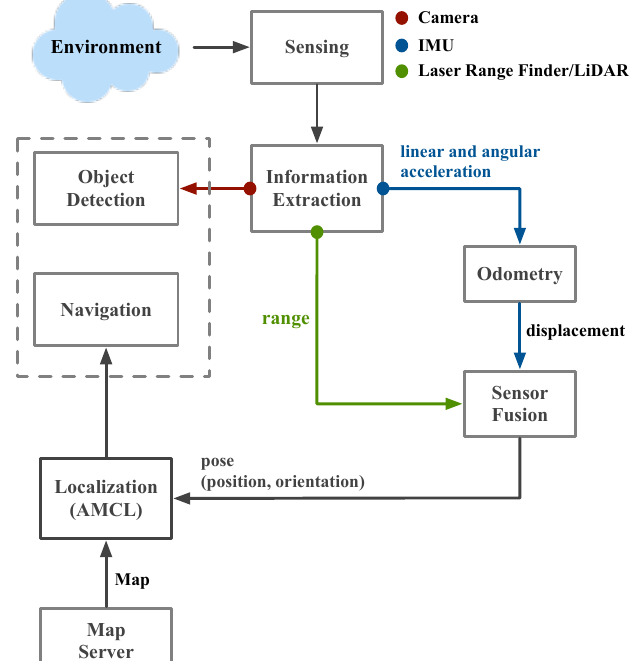
Figure 7. Off-line map-building workflow.